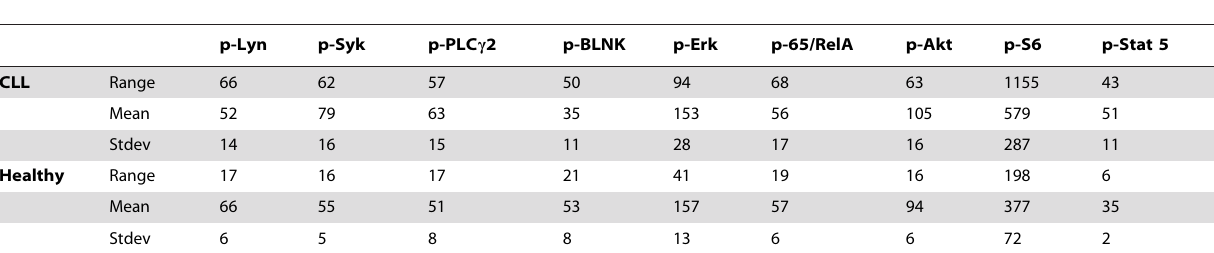
Table 2. Range of basal phosphorylation levels (MFI) of BCR signaling molecules in CLL and healthy B